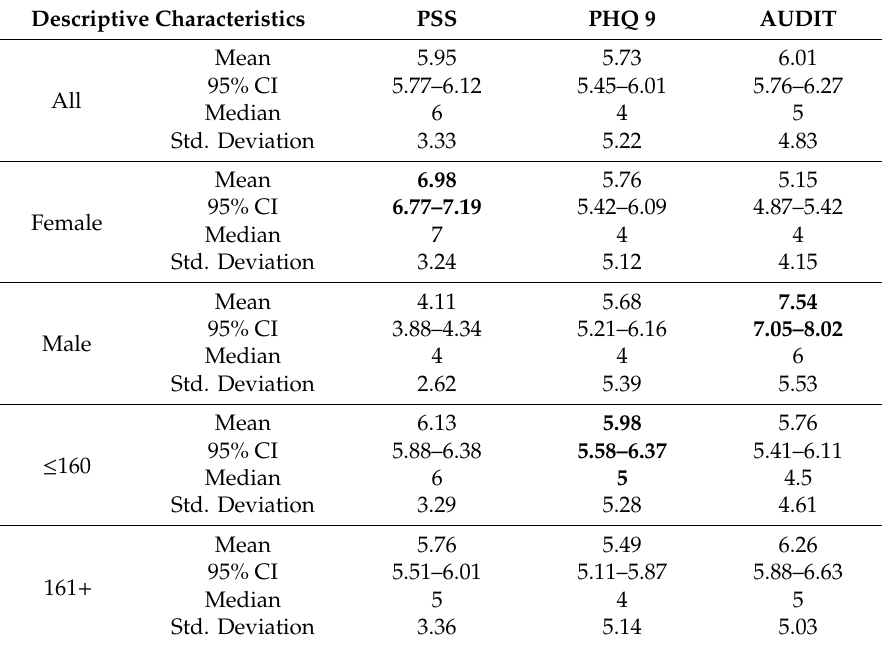
Table 2. Descriptive analysis of behavioural and mental